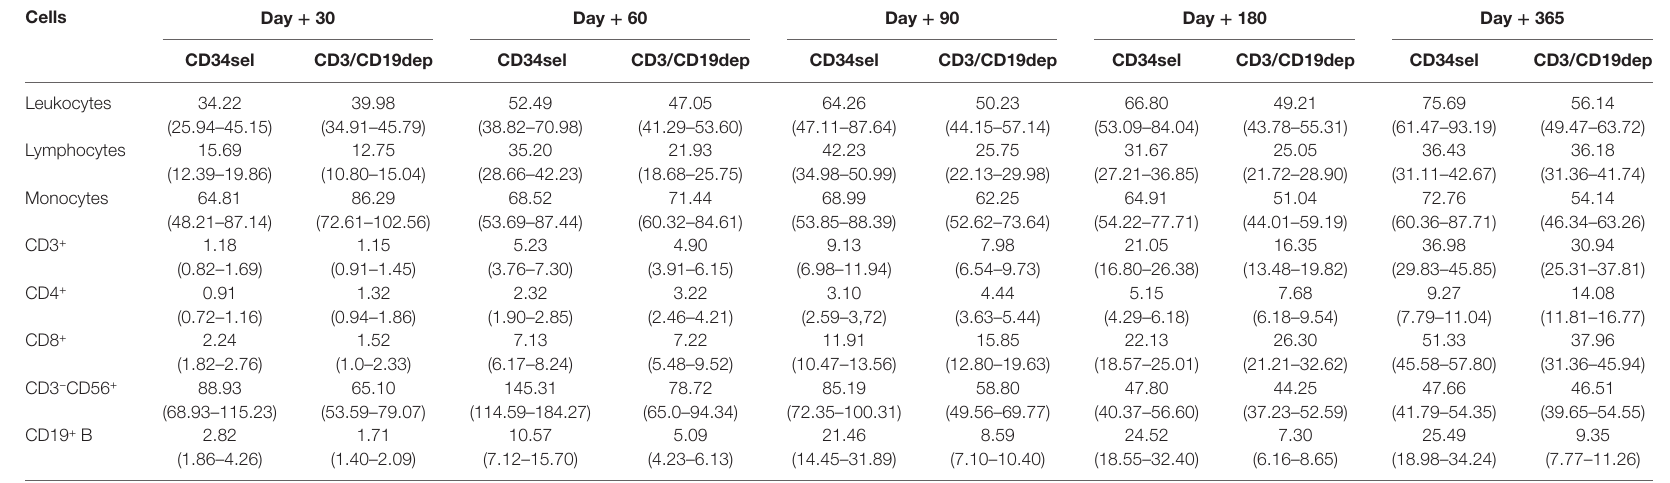
The table shows the predicted percent values (% of the norm values) arise from our joint model with 95% confidence interval at + 30, + 60, + 90, + 120, and + 365 days after transplantation. The values were obtained for children in complete remission (CR) at time point of haplo-SCT. The percent values represent the fraction with respect to the predicted age-matched norm values by Huenecke et al. (27). See also Table S2A in Supplementary Material for a representation of absolute numbers for predicted values for a 10-year-old